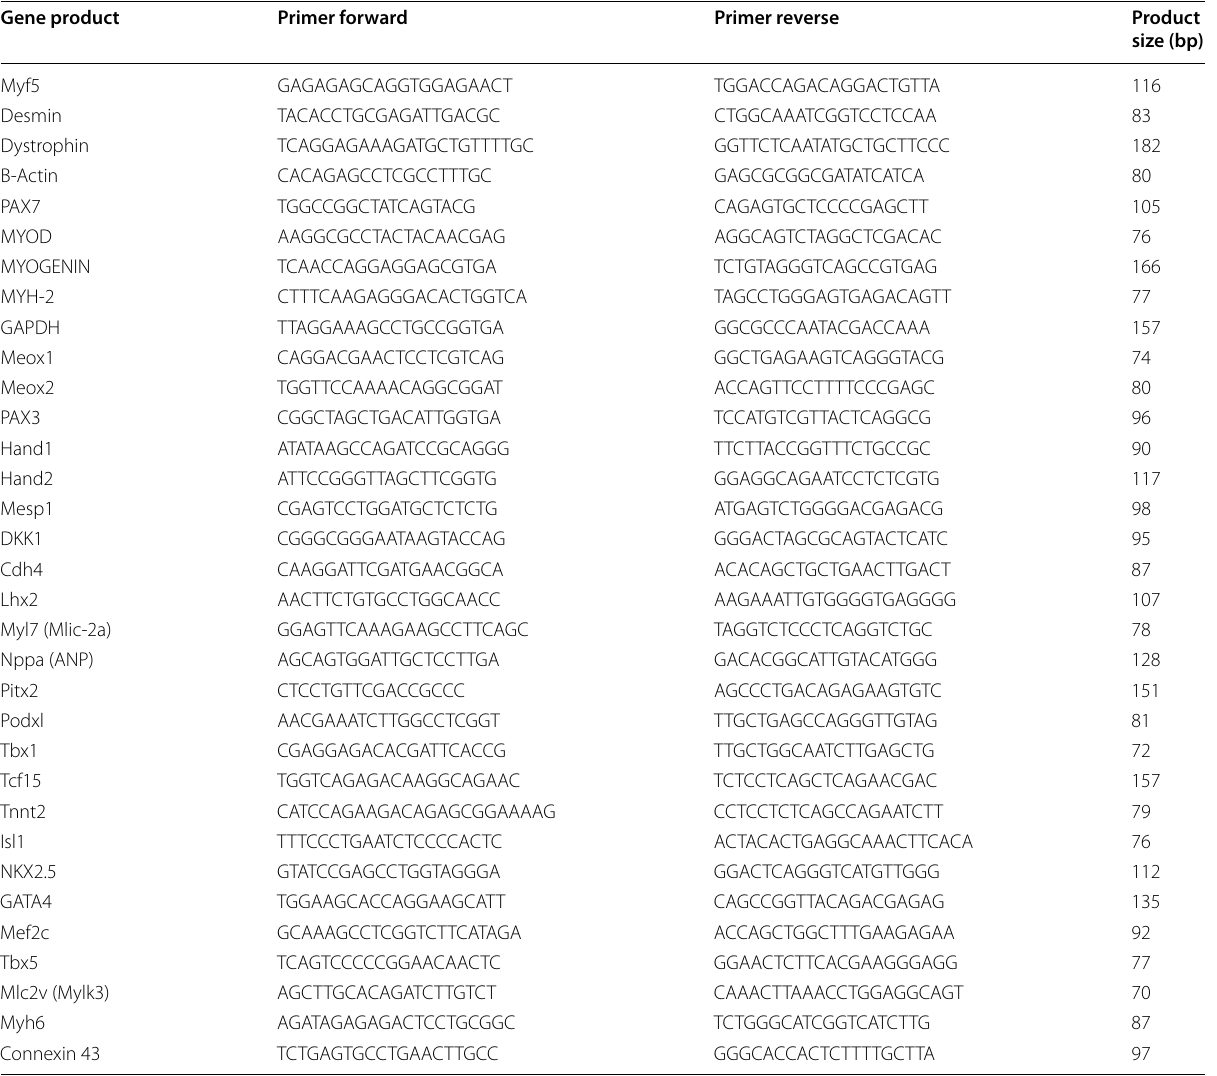
Table 1 The PCR primers for real-time PCR (Integrated DNA Technologies, IDT) Gene